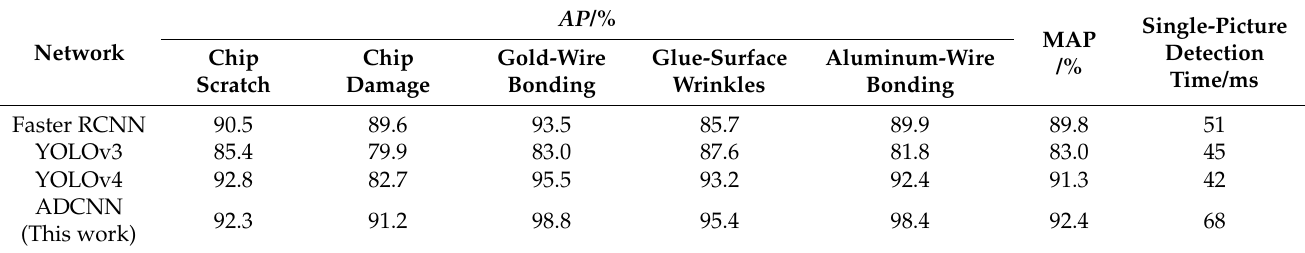
Table 3. Comparison of detection results of different networks.